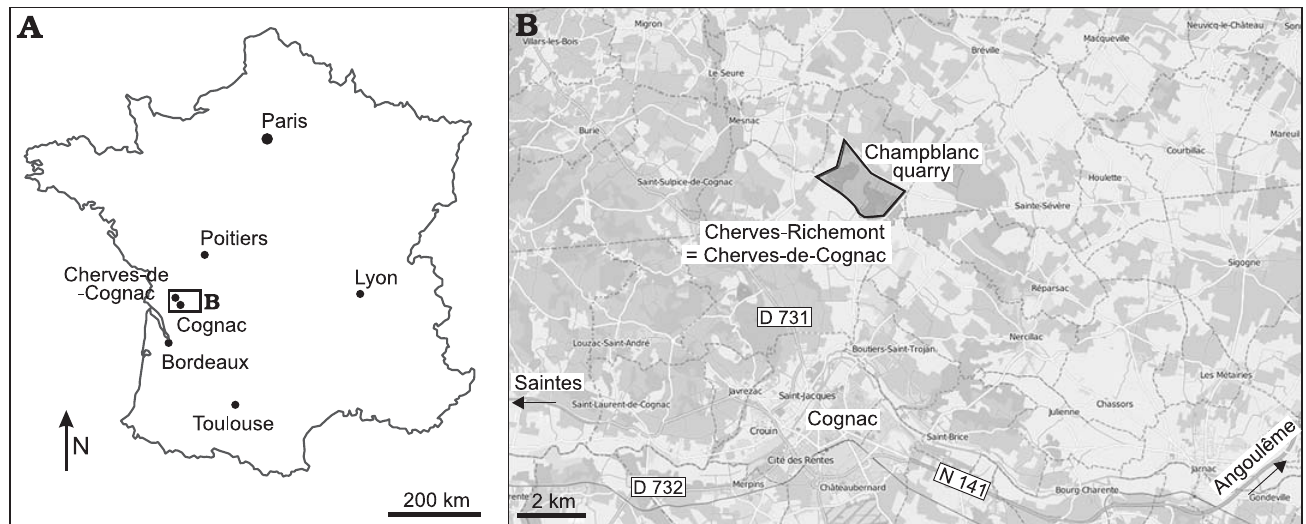
Fig. 1. Location of the Cherves-de-Cognac site near the town of Cognac, Charente, southwestern France ( A ), area of the Champblanc Quarry ( B , modified from